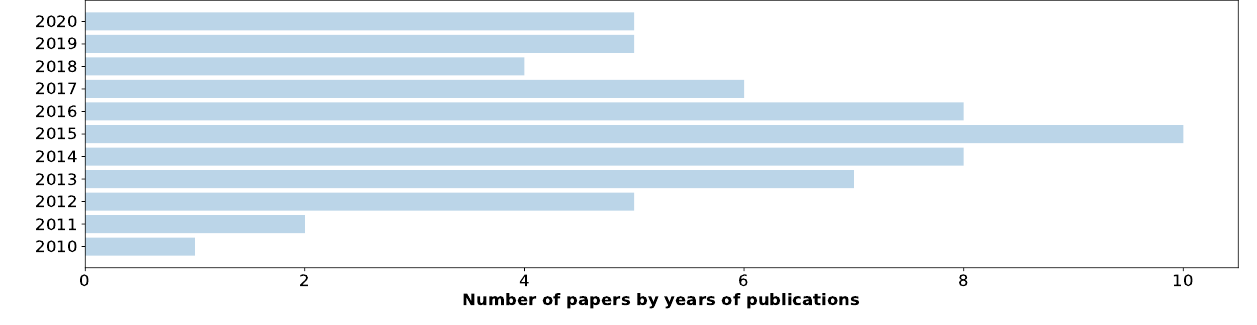
Figure 2. Distribution of papers from 2010 to 2020.